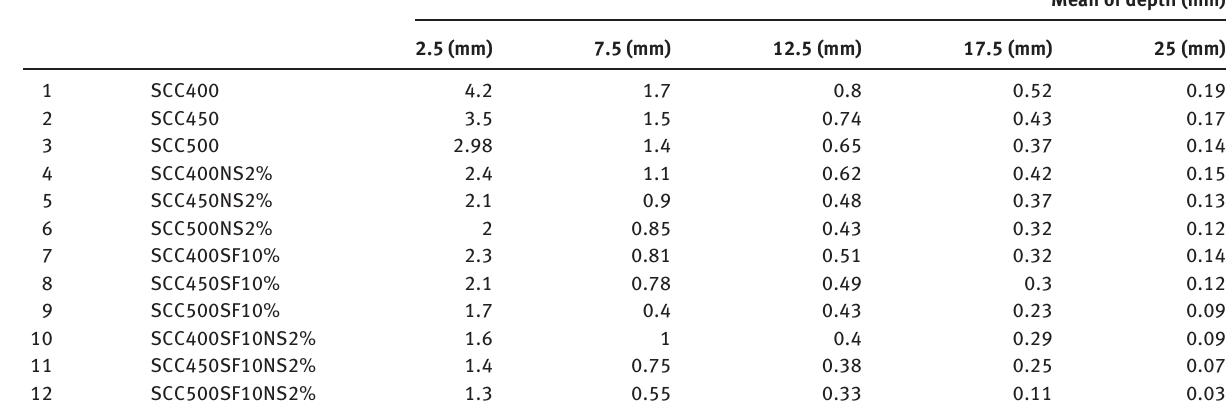
Table 7 Cl ion percentage at different average depths of the concrete samples. probable. In the mixtures containing 2 % NS, 10 % SF, and